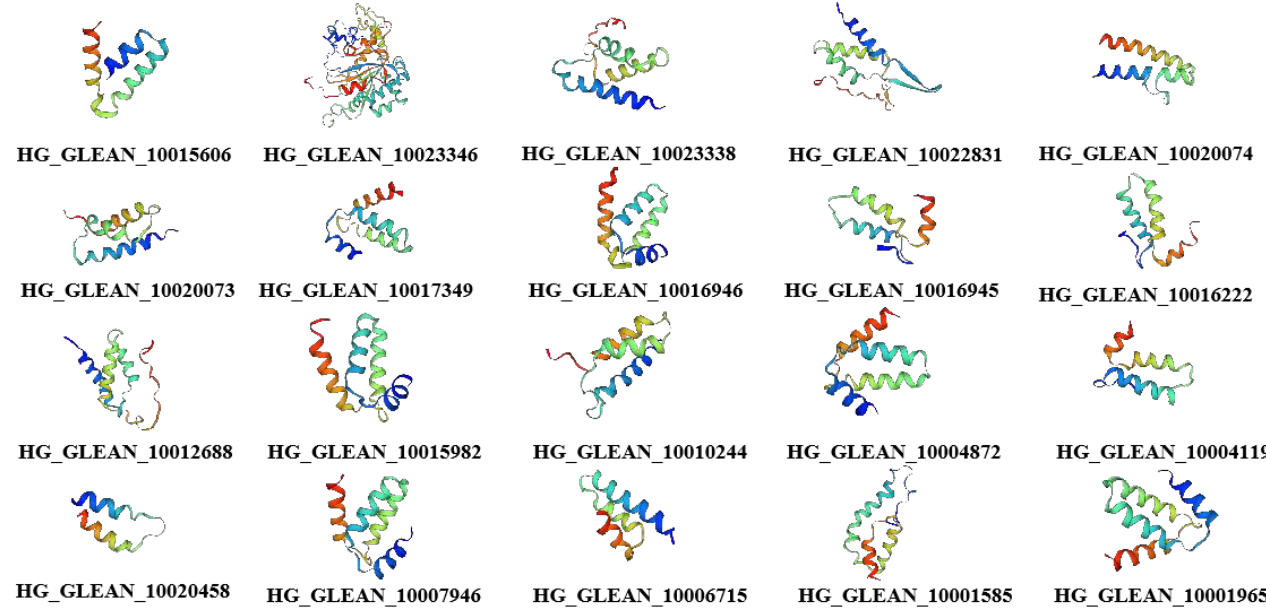
Figure 3. Predicted three-dimensional structures of bottle gourd OVATE family proteins.